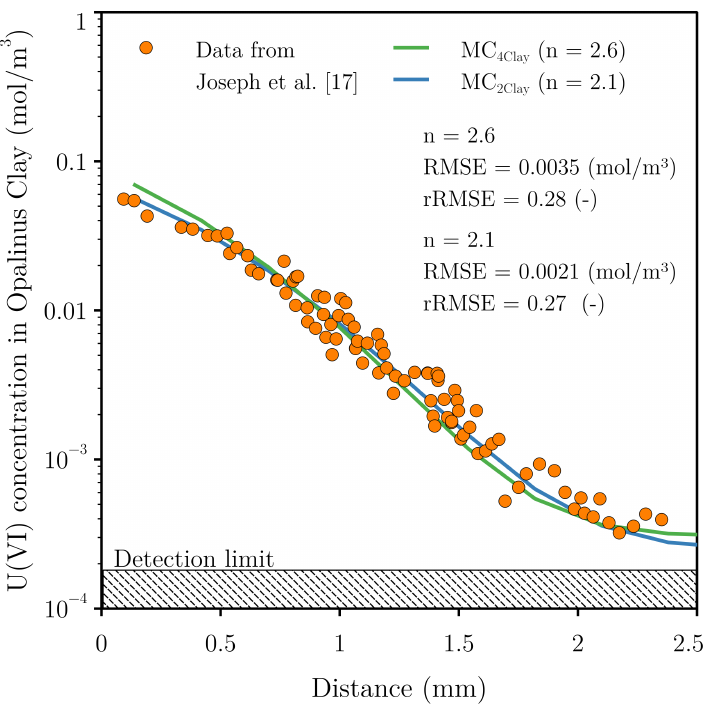
Figure 2. For the model concept considering all clay minerals (kaolinite, illite, montmorillonite and chlorite) for sorption (MC 4 Clay , green line), the modeled results match with the experimental data (dots) of the diffusion experiment with U(VI) and Opalinus Clay of the sandy facies for an exponent n of 2.6. For the model taking into account only the two clay minerals illite and montmorillonite (MC 2 Clay , blue line), n is